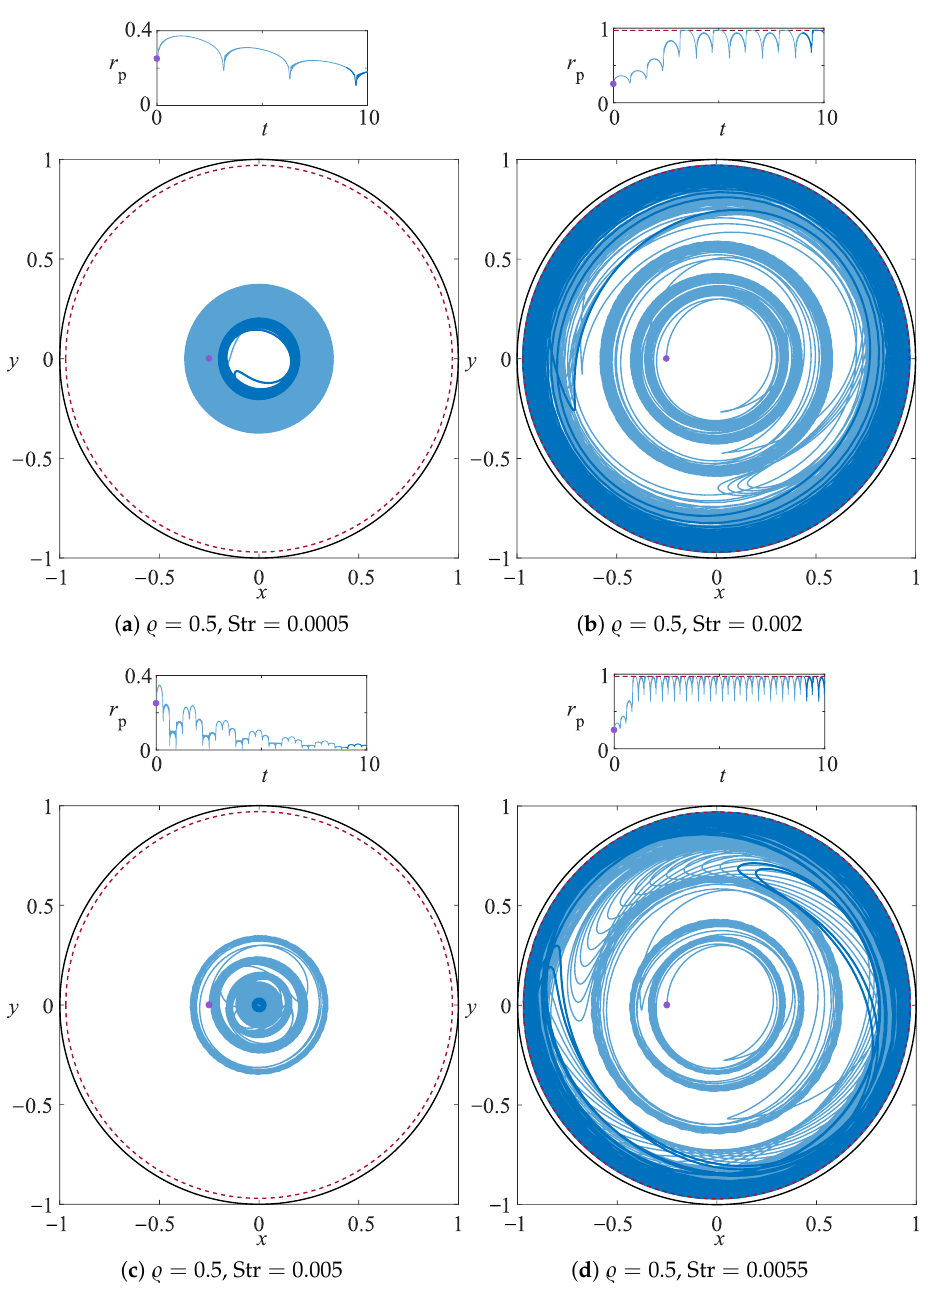
Figure 2. Radial coordinate r p of a particle trajectory for (cid:36) = 0.5, St = 1 and Str = 0.005, 0.002, 0.005, and 0.0055. The trajectories are integrated for t = 10 and they are denoted by the light-blue line. The darkblue solid line shows the last 10% of the particle orbit and the purple dot its initial position. The red dashed line identifies the sliding surface of the PSI model, which surface is at distance ∆ = a from the driving